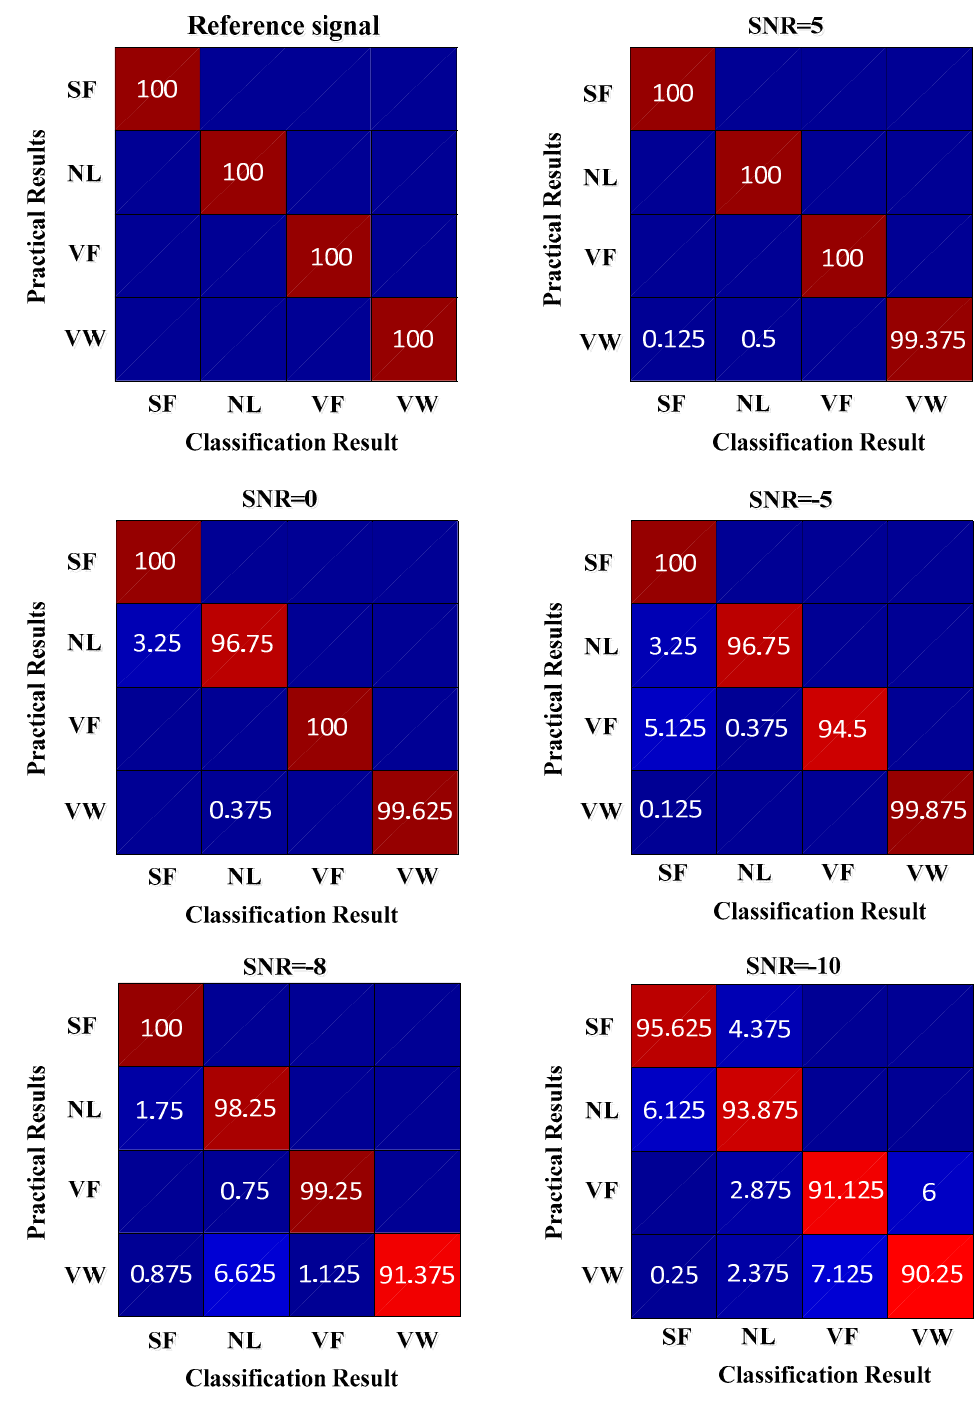
Figure 10. Classification results.